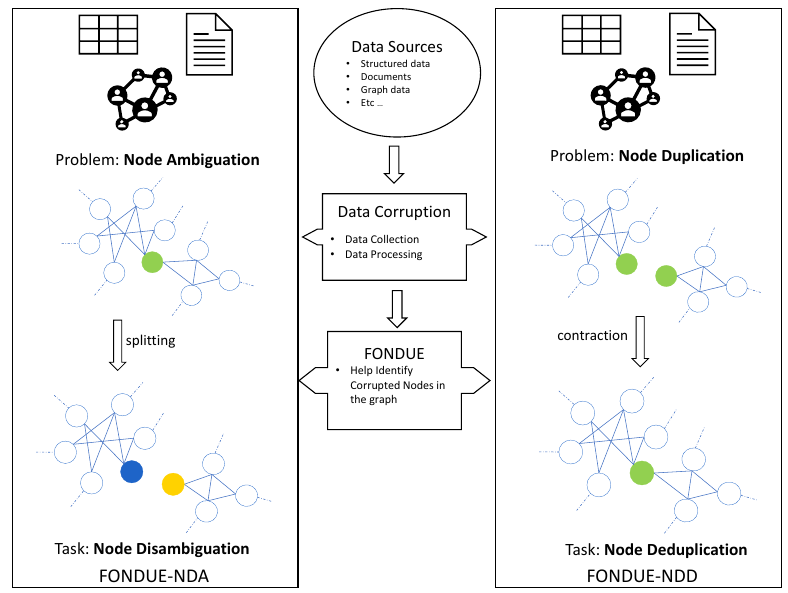
Figure 2. FONDUE pipeline for both NDA and NDD. Data corruption can lead to two types of problems: node ambiguation (e.g., multiple authors sharing the same name represented with one node in the network) in the left part of the diagram, and node duplication (e.g., one author with name variation represented by more than 1 node in the network). We then define two tasks to resolve both problems separately using